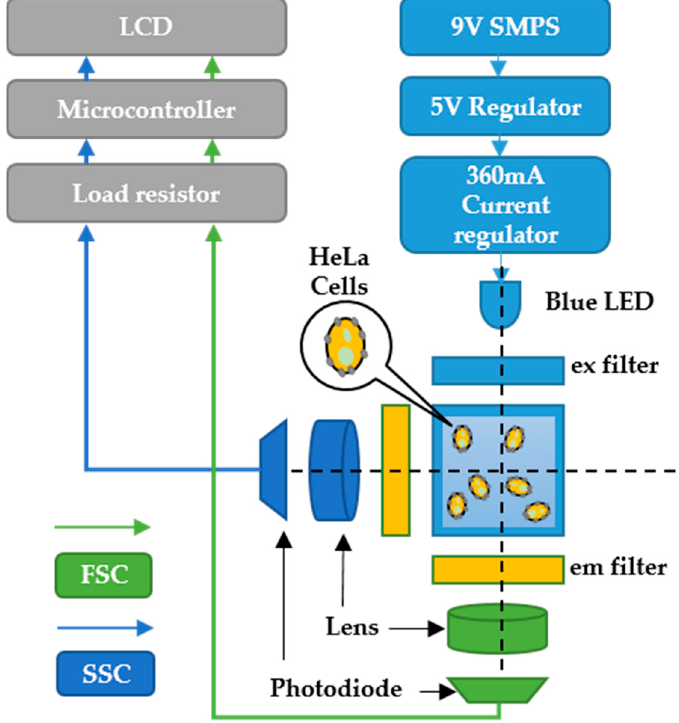
Figure 4. Schematic design of the fluorescence detection system.